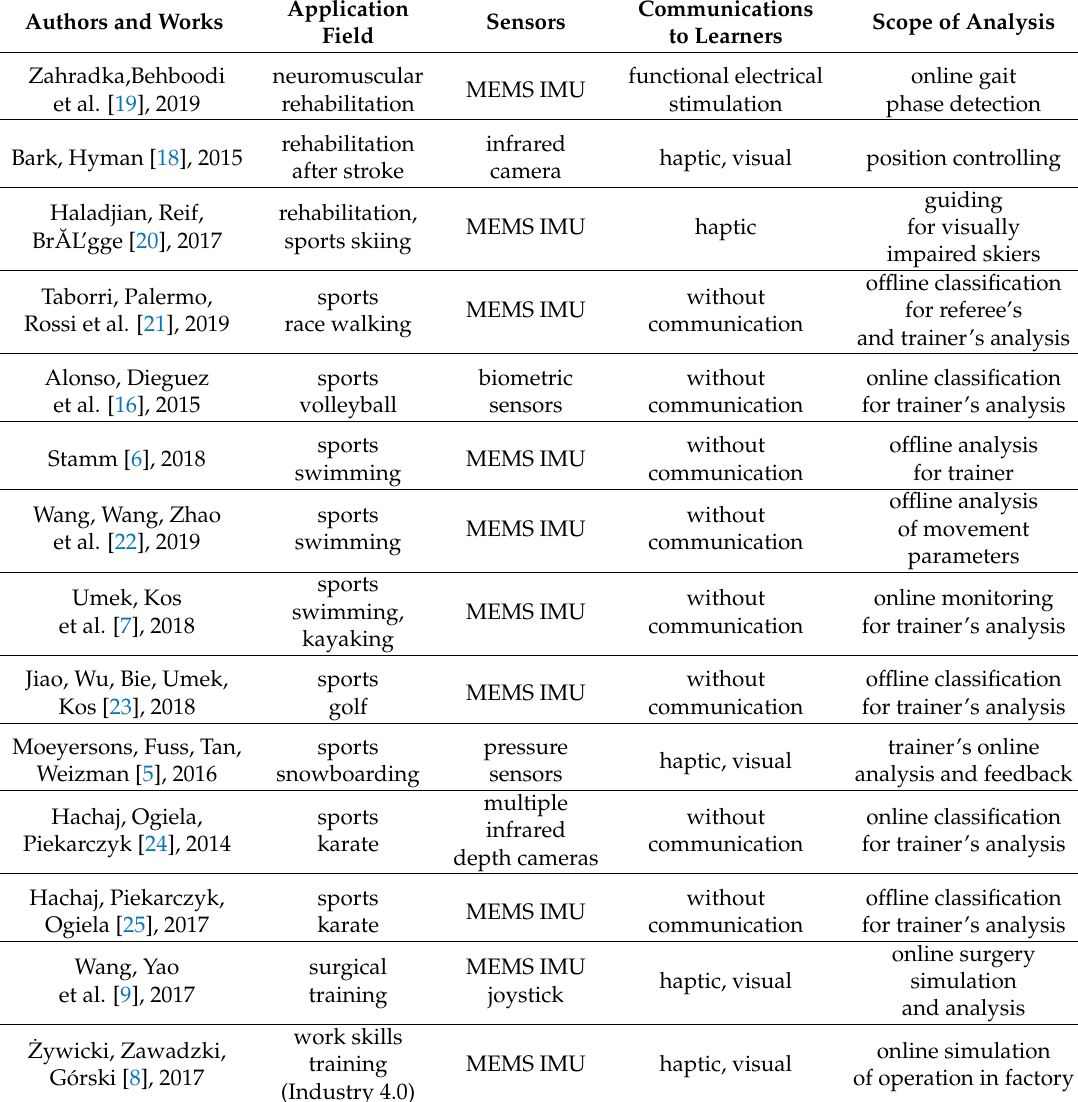
Table 1. A brief review of selected teaching systems using different paradigms and approaches, including sensor types, methods of communication with the user, and the aim and scope of the analysis. Authors and